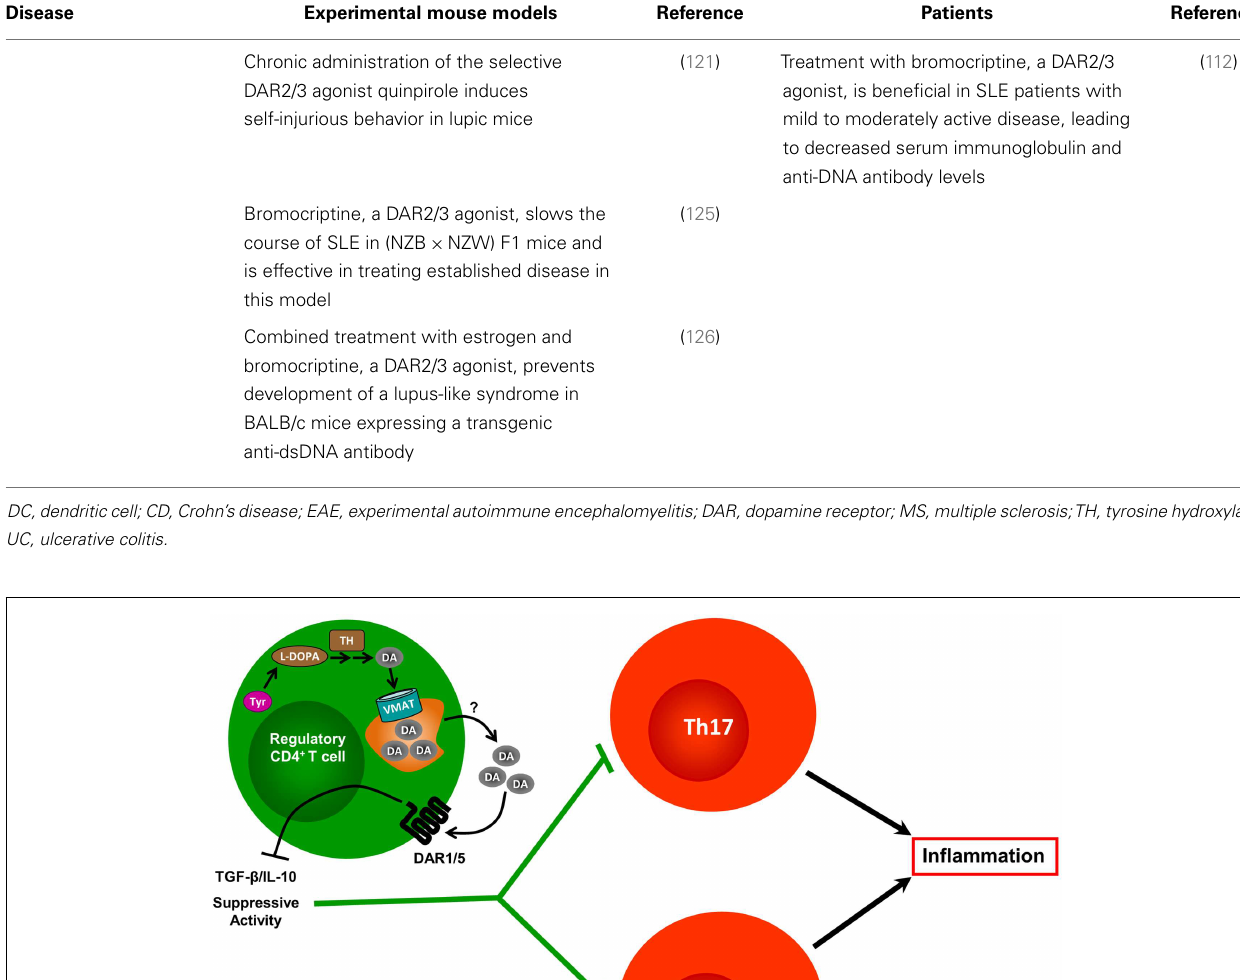
interact with DARs expressed on theTreg cell surface, but also with DARs present on DCs and effector CD4 + T cells (not depicted). Treg-derived DA interaction with DAR1/5 expressed byTregs, reduces the expression of IL-10 andTGF- β , and weakens theTreg’s suppressive activity exerted over effector CD4 + T